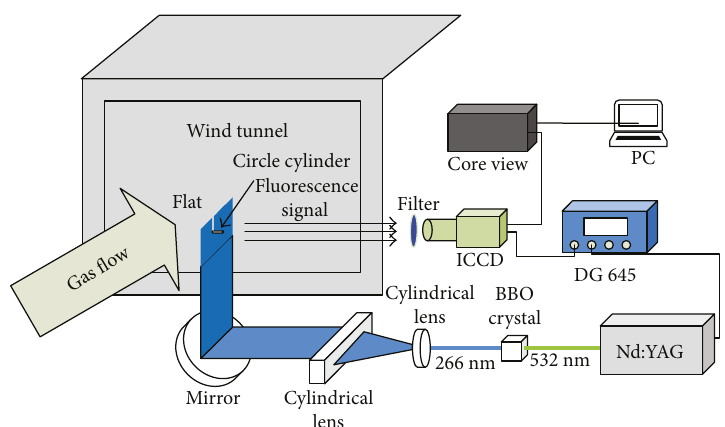
Figure 1: Experimental set-up schematic